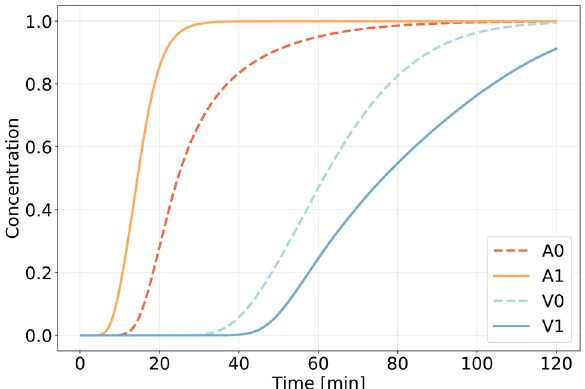
Figure 6. Time plots of average concentrations at the point of measurement in the idealized artery (A0) and vein PVS (V0) together with the average concentrations in the image-based artery (A1) and vein (V1) PVS. The difference between arterial and venous PVS transport is larger in the image-based geometries, but there is a significant delay in venous PVS compared to arterial PVS in both cases.